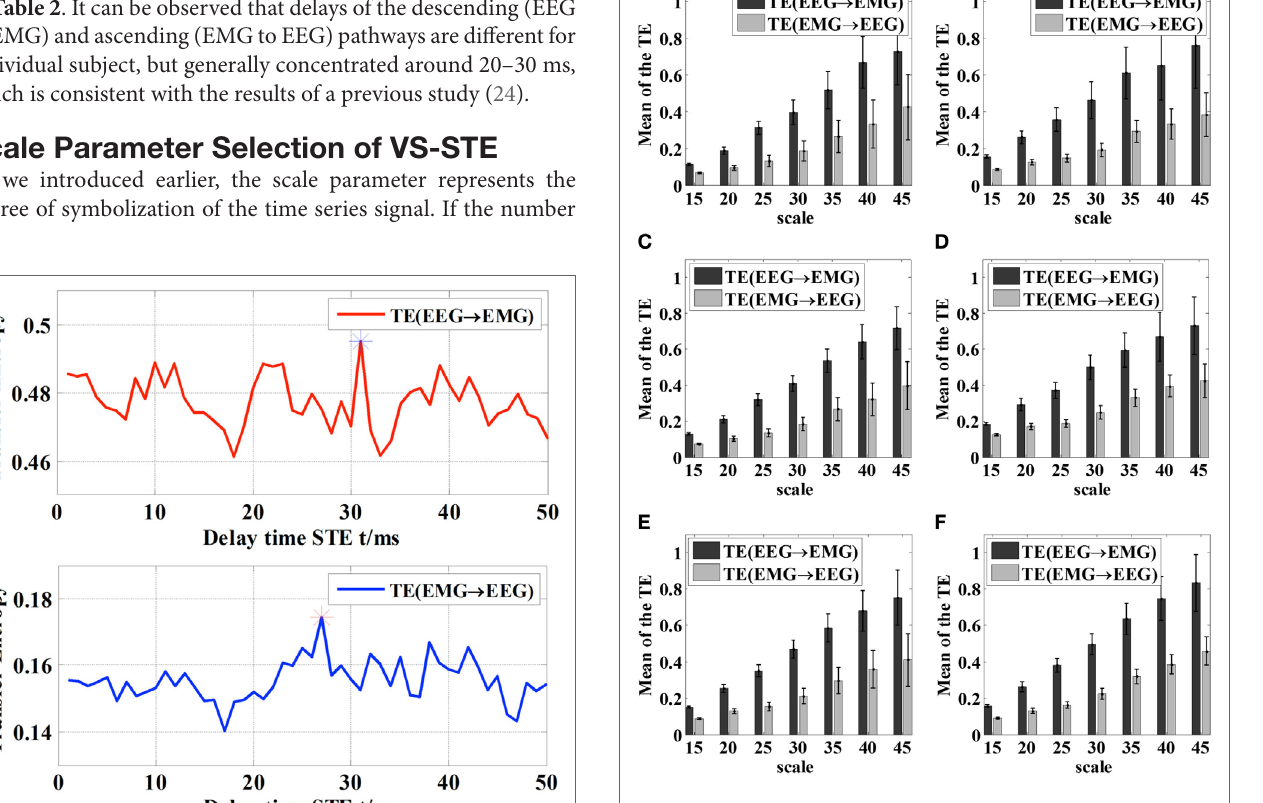
FigUre 4 | Mean and SD of the STE hand gripping task with respect to different scale parameters. (a) Left hand 5 kg gripping; (B) right hand 5 kg gripping; (c) left hand 10 kg gripping; (D) right hand 10 kg gripping; (e) left hand elbow bend; (F) right hand elbow